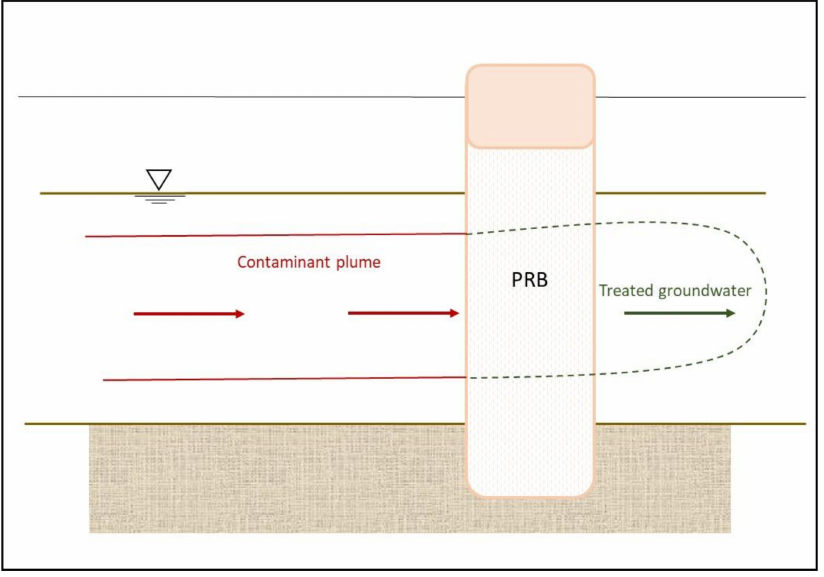
Figure 3. The layout of the process involved in permeable reactive barrier